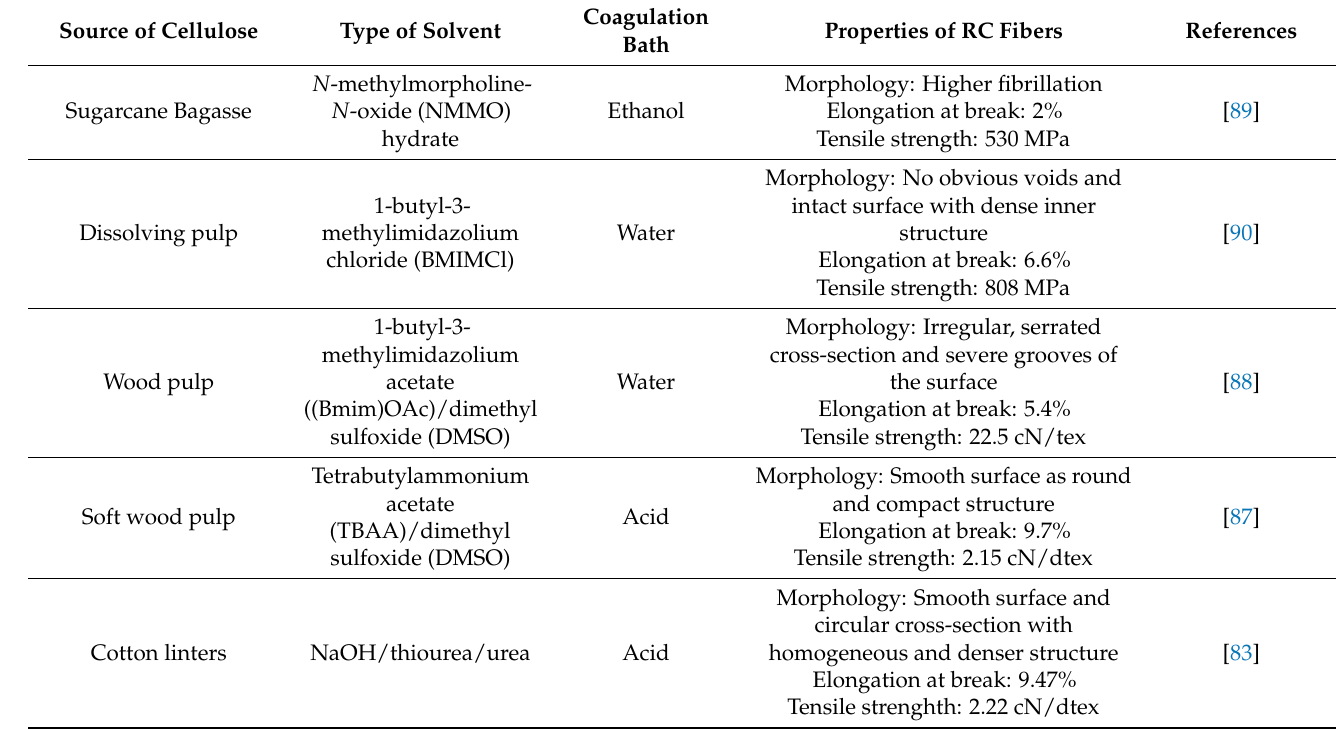
Table 4. Properties of RC fiber in different types of